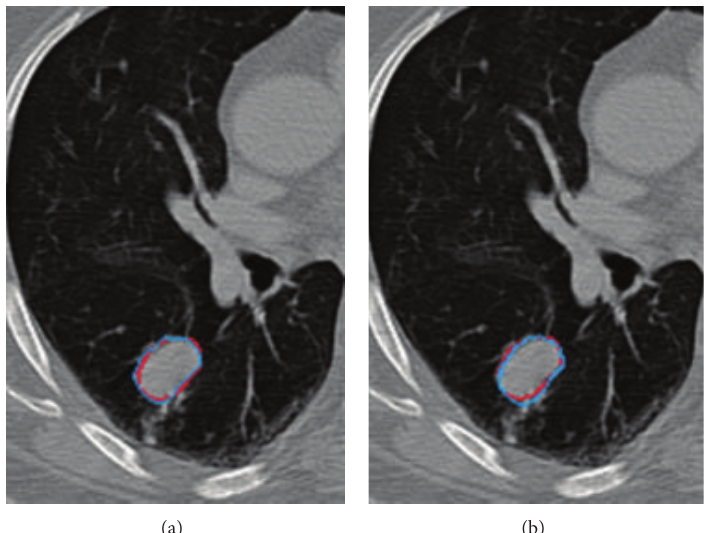
Figure 4: Comparison of automated contouring methods with ground-truth in case 2. (a) Manual contour (red) compared with MPSL (turquoise) based segmentation of GTV. (b) Manual contour (red) compared with DIR based contour (turquoise).